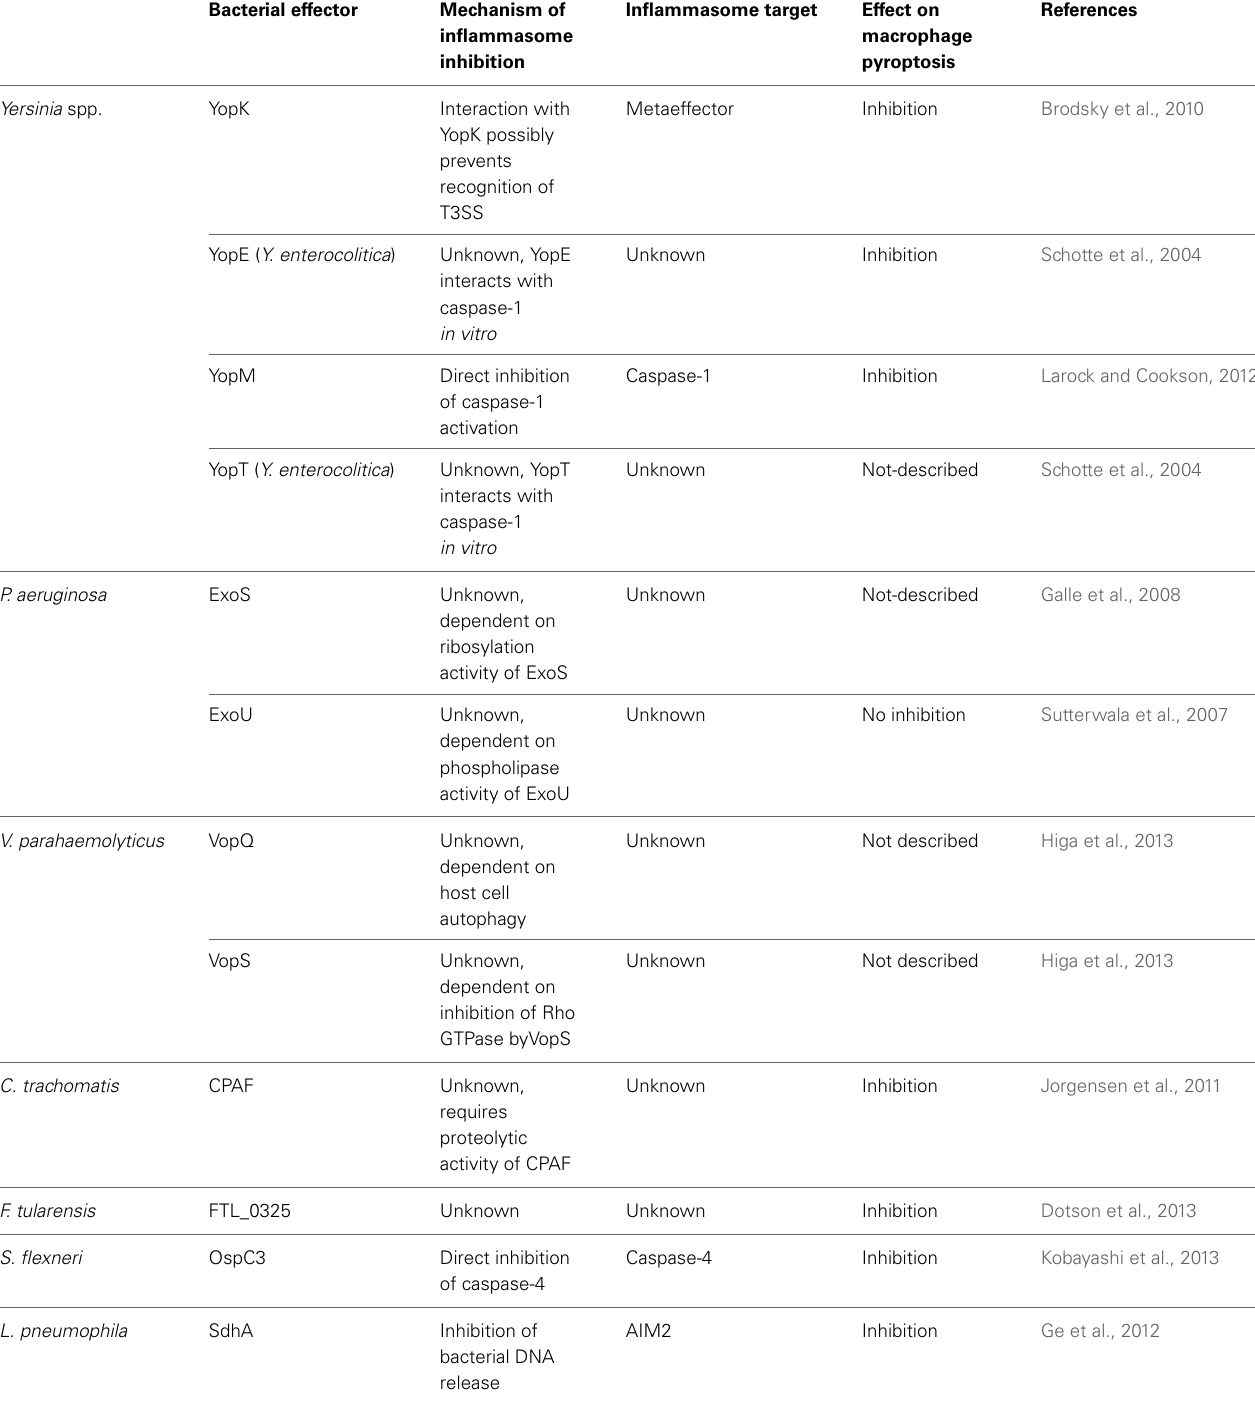
Table 1 | Summary of bacterial effectors that suppress inflammasome activation and their role on suppression of pyroptosis, as discussed in the main